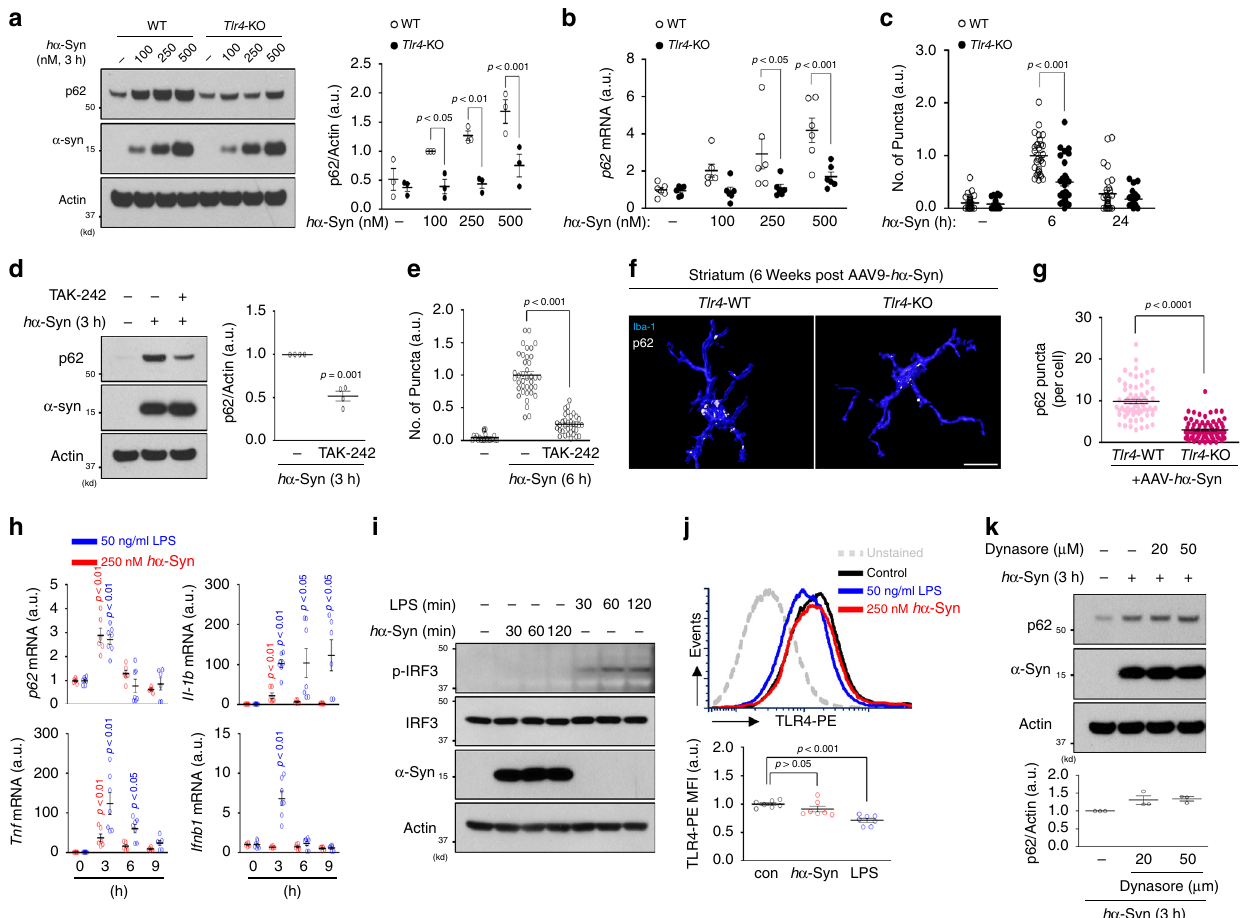
Fig. 4 α -synuclein-induced p62 upregulation requires TLR4. a , b , c Microglia obtained from WT mice and Tlr4 -KO mice were treated with h α -Syn protein and assayed for W.B ( a , n = 3), RT-qPCR ( b , n = 6) or for immunostaining ( c , n = 30). Band intensities were quanti fi ed in the right panel of a . The number of h α -Syn/ubiquitin-positive puncta was quanti fi ed ( c ). p -values were calculated by two-way ANOVA with Bonferroni post hoc test. In ( a ), F(3,16) = 3.381, p = 0.0443 for h α -Syn-genotype interaction; F(3, 6) = 11.46, p = 0.0003 for h α -Syn; F(1,16) = 43.09, p = 6.51E-06 for genotype. In b , F(3,40) = 3.199, p = 0.0334 for h α -Syn-genotype interaction; F(3,40) = 8.326, p = 0.0002 for h α -Syn; F(1,40) = 21.77, p = 3.41E-05 for genotype. In c , F(2,174) = 12.56, p = pretreated with TAK-242 and treated with 250 nM h α -Syn protein. The protein levels of p62 and the number of h α -Syn/ubiquitin-positive puncta were determined by W.B ( d , n = 4) and immunostaining ( e , n = 35), respectively. p -values were calculated by unpaired two-tailed Student ’ s t test ( d , p =